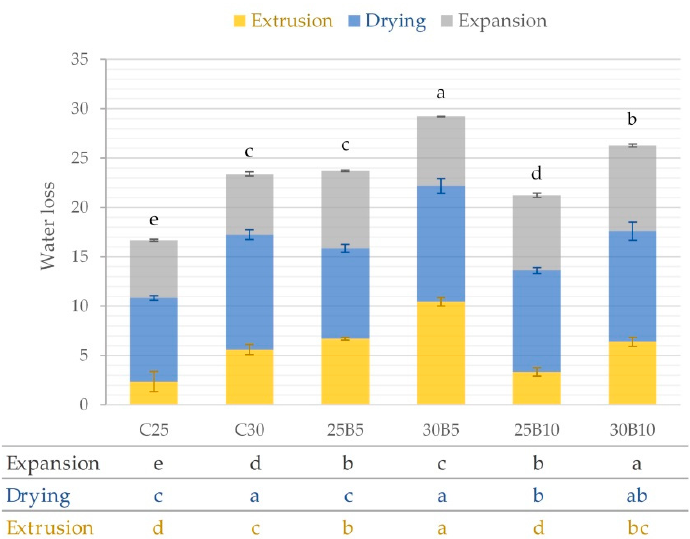
Figure 5. Mean values (and standard deviations) of water loss due to extrusion, drying, and expansion for each snack. The table contains the letters representing the homogeneous groups established by ANOVA ( p < 0.05) for water losses at each stage of production.